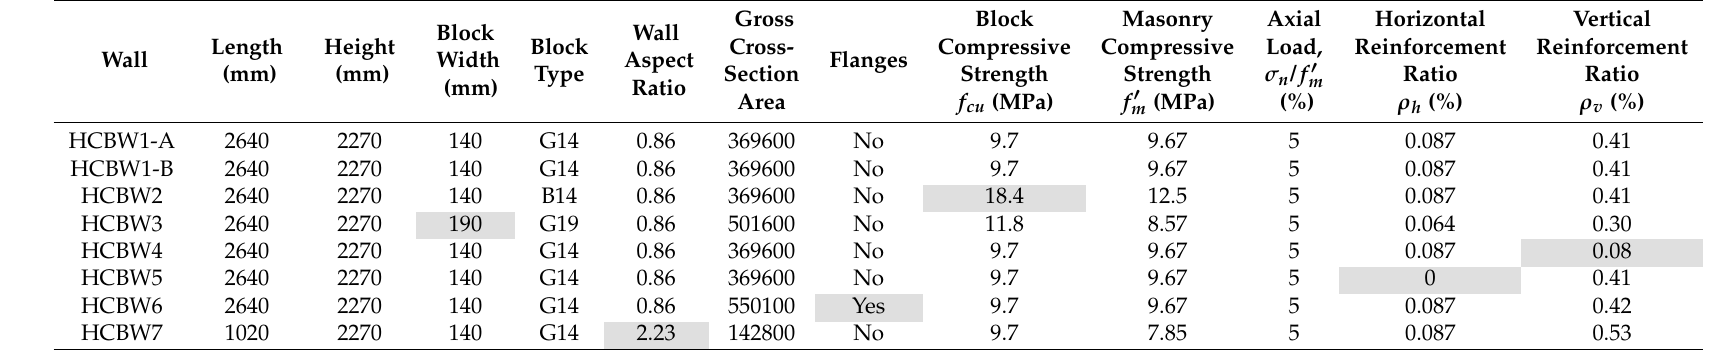
Table 1. Summary of wall